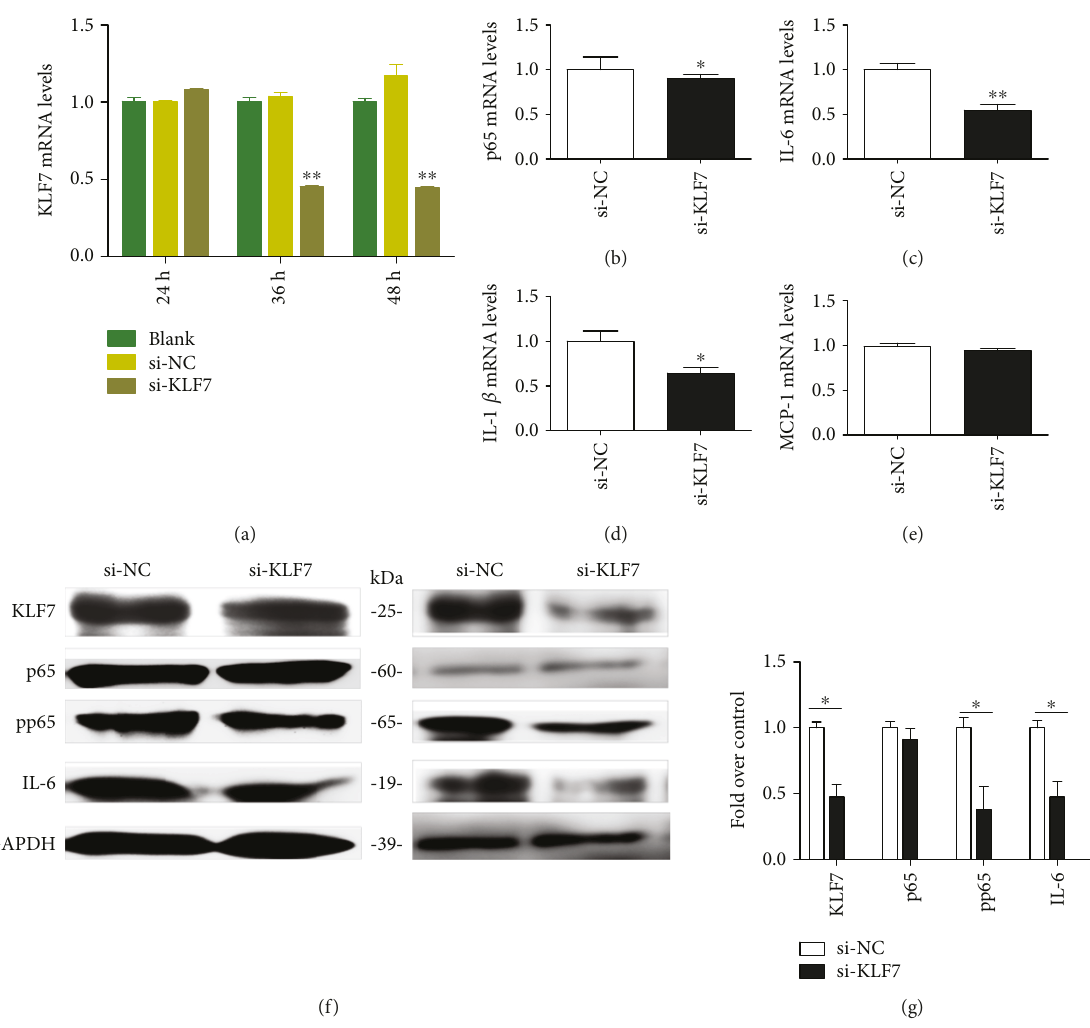
Figure 4: The KLF7 mRNA expression level in adipocytes was measured after KLF7 was downregulated for 24 h, 36h, and 48h, with 100 μ mol/L as the optimal concentration (a). After 48 h of KLF7 downregulation, the mRNA and protein expressions of in fl ammatory cytokines in adipocytes were measured (b – f). Grayscale scanning of proteins (g) (siKLF7: transfected siRNA of KLF7; siNC: transfected negative control of siRNA). The data for each group is derived from three replicates of experimental data. One-way ANOVA (a), T test (b – e, g), ∗ P < 0 05 , ∗∗ P < 0 01 ; the di ff erence was statistically signi fi